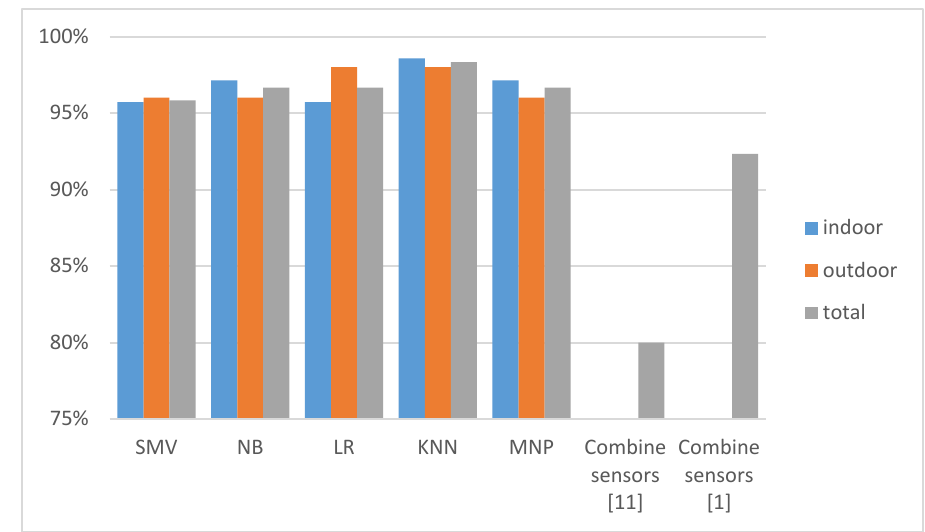
Figure 11. Indoor/outdoor (I/O) detection accuracy. Figure 11. Indoor / outdoor (I / O) detection